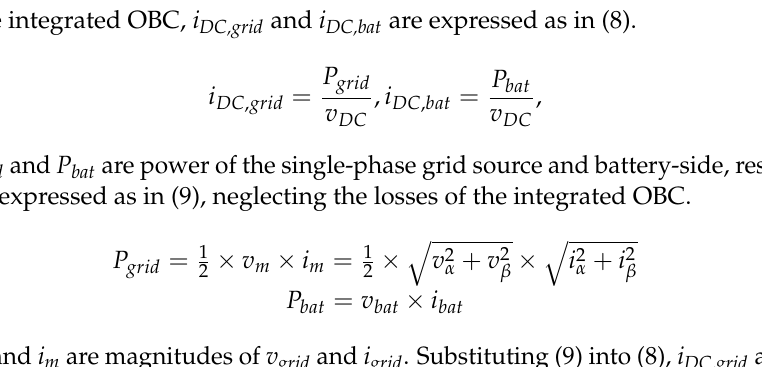
Figure 6. Block diagram of the integrated OBC with DC-link current